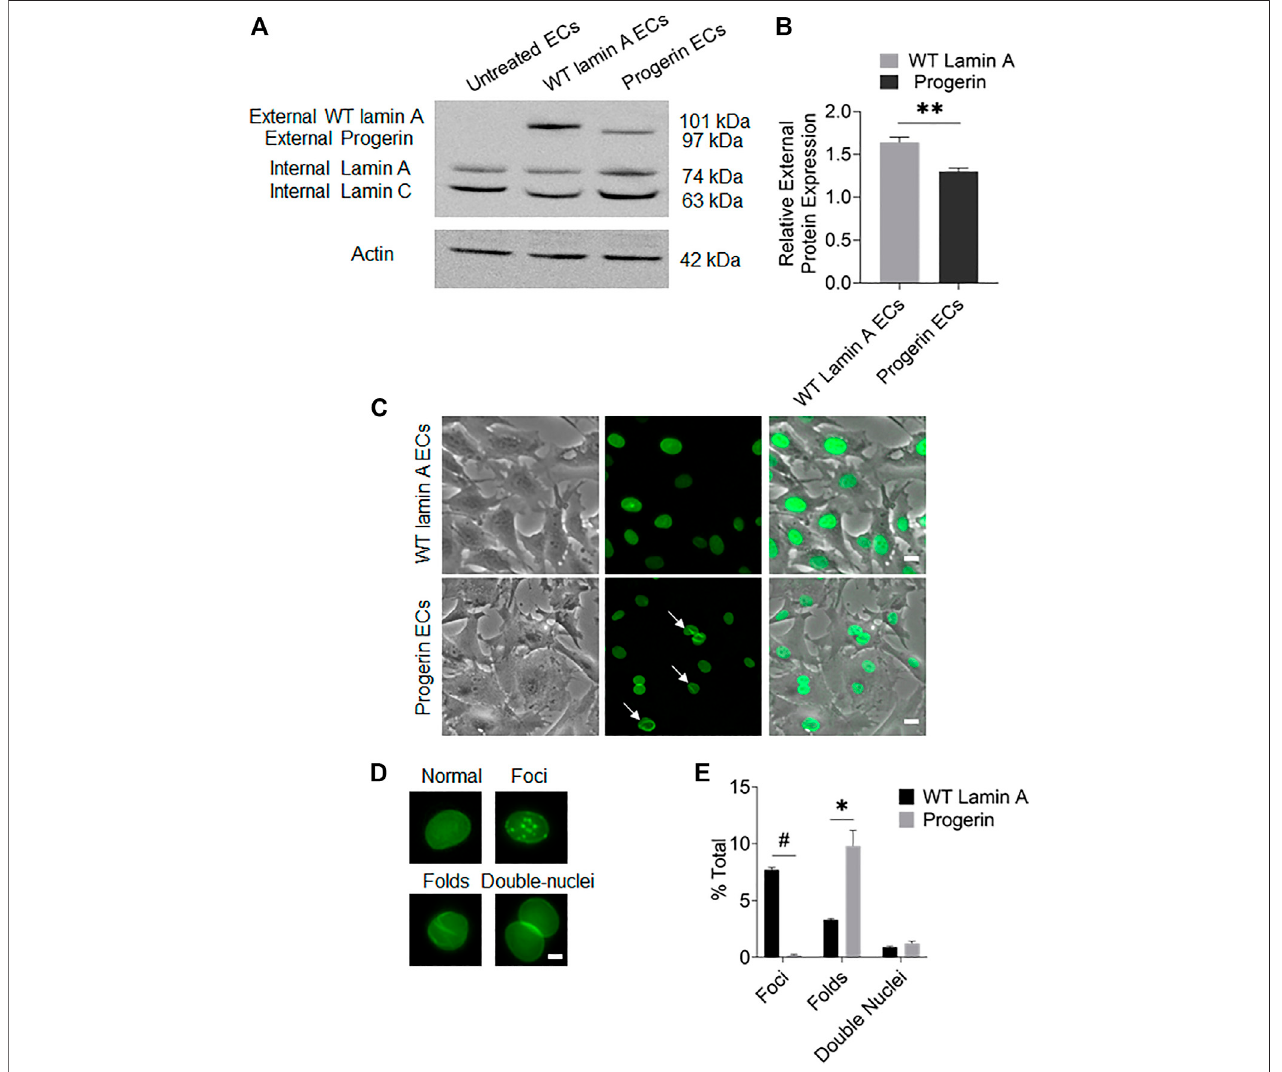
FIGURE 1 | Characterization of targeted protein expression in transduced ECs. (A) Western blot showed the presence of endogenous lamin A and exogenous GFP-conjugated proteins in transduced ECs. The sizes of GFP-fused proteins were determined by adding the molecular weights of GFP and the fused protein. (B) Quanti fi cation of wild-type lamin A and progerin protein expression levels in wild-type lamin A- and progerin-expressing ECs, respectively. (C) Representative images of cellsshowedthattheGFP-conjugatedproteinswerespeci fi callylocatedatnuclei.AsubstantialpopulationofcellswithGFP-progerinexpressionshowedabnormal nuclear shapes (indicated by white arrows). Scale bar: 20 µm. (D) Examples of wild-type lamin A-expressing ECs with or without unusual nuclear shapes, including nuclear foci, folds and double nuclei. Scale bar: 5 µm. (E) The graph showed the frequency of unusually shaped nuclei in WT lamin A- and progerin-expressing cell population. * p < 0.01, # p <